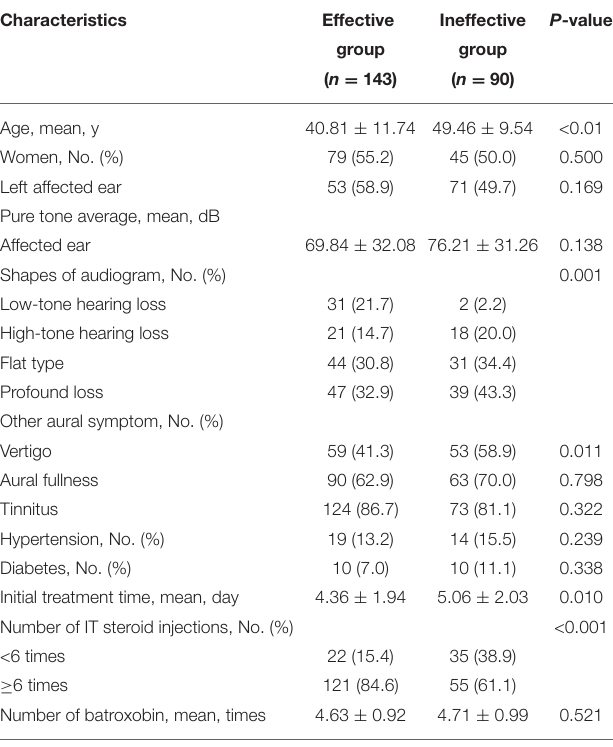
TABLE 2 | Comparison of prognosis between effective group and ineffective group.